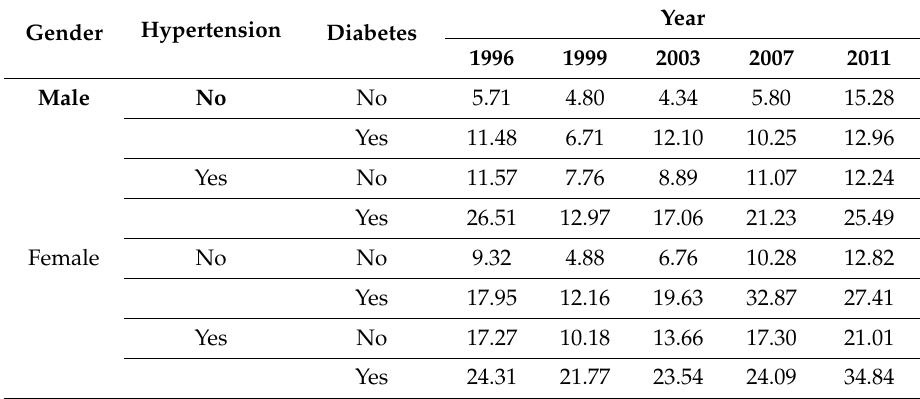
Table 2. The percentage (%) of respondents middle-aged and over who were disabled from 1996 to